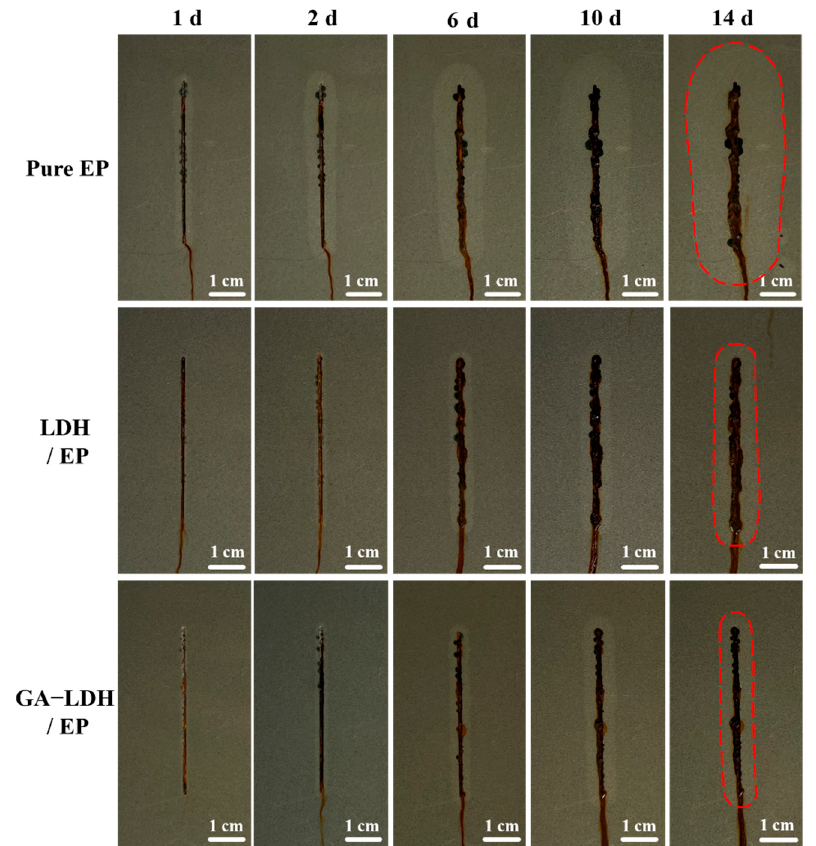
Figure 11. Optical photographs of pure EP, LDH/EP, and GA − LDH/EP coatings after neutral salt spray tests at different times. The area where the coating blisters and peels off around the scratched region is plotted by the red dotted line.